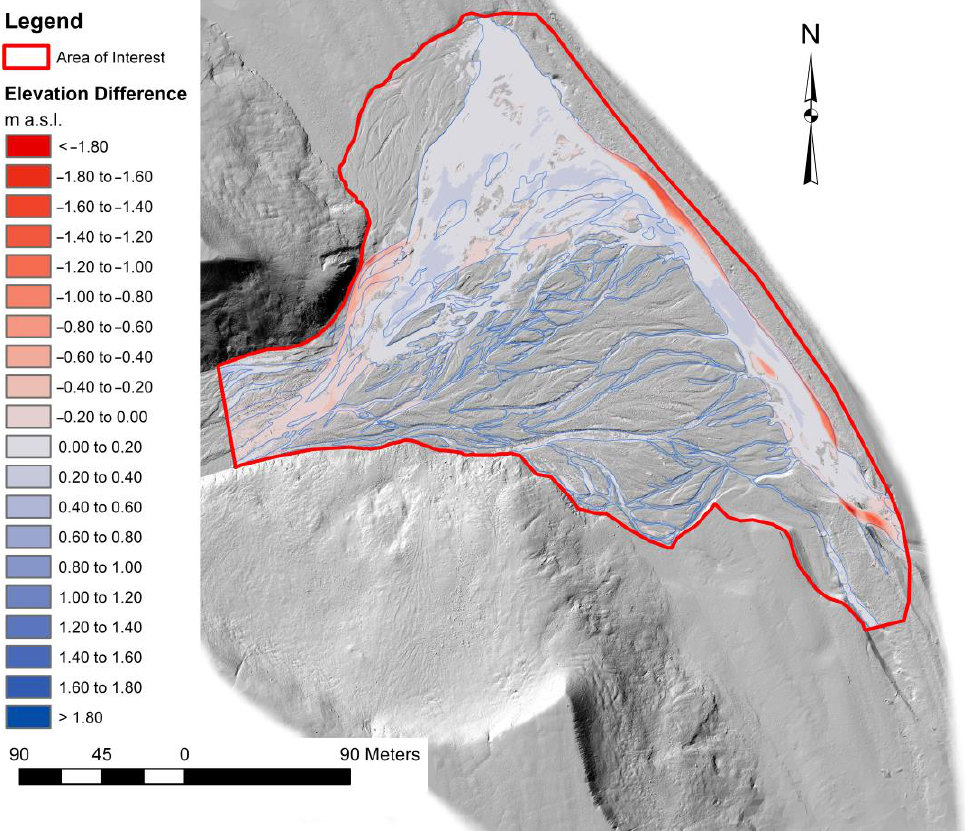
Figure 5. Geomorphic changes in the Scott River alluvial fan area of interest for the 2013 flood period. AoI for the entire alluvial fan with MinLoD = 0.02. Hillshades map is shown after DoD for context.